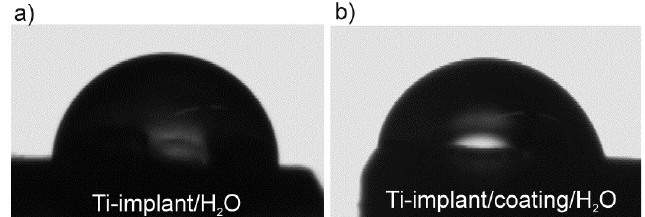
Figure 4. Optical micrographs of a water drop on ( a ) the Ti-implant surface and ( b ) the Ti- implant/bioactive coating